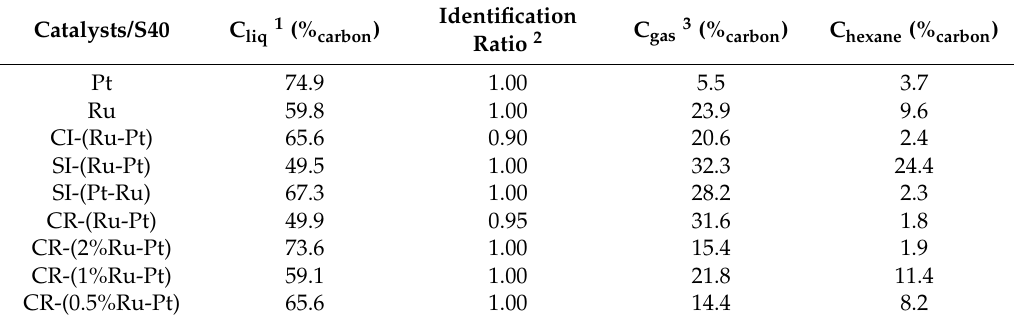
Table 3. Carbon yields in aqueous and gaseous phases obtained at 80–96% sorbitol conversion for the Ru–Pt/S40 bimetallic catalysts prepared by co-impregnation (CI), successive impregnations (SI) and catalytic reduction deposition (CR), as well as for Pt/S40 and Ru/S40 monometallic catalysts.